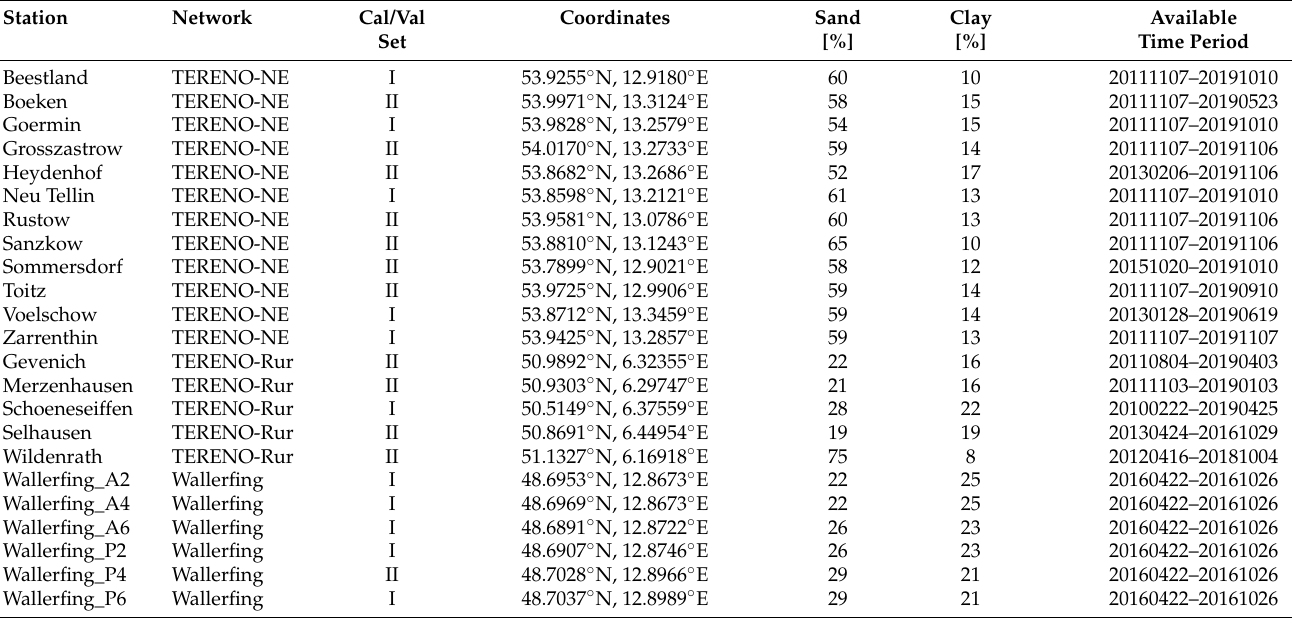
Table 1. Overview of soil moisture measurement stations that are used in calibration and validation procedure. Cal/Val set states the assignment to the respective random calibration and validation set.